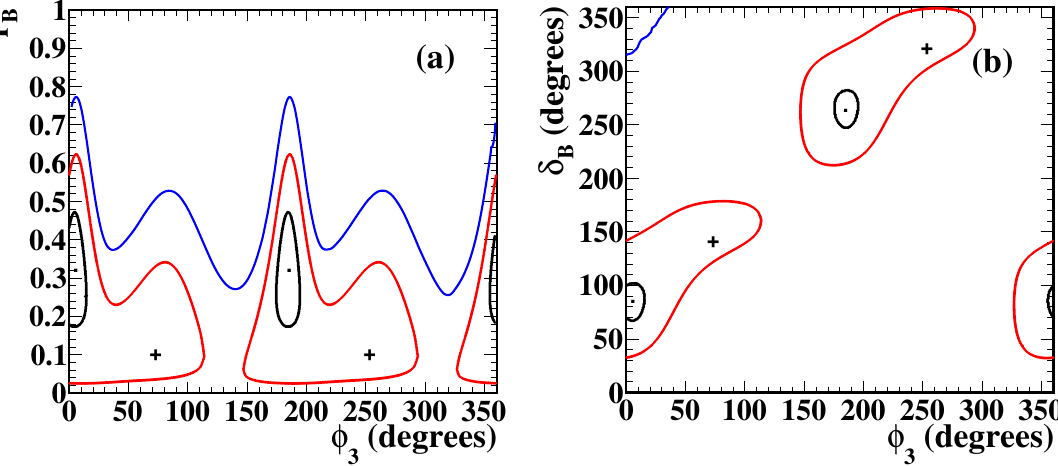
Figure 9 . Projection of the statistical con(cid:12)dence intervals in the (a) (cid:30) 3 (cid:0) r B and (b) (cid:30) 3 (cid:0) (cid:14) B planes. The black, red, and blue contours represent the one, two, and three standard deviation regions, respectively. The crosses show the positions of the world-average values [36].